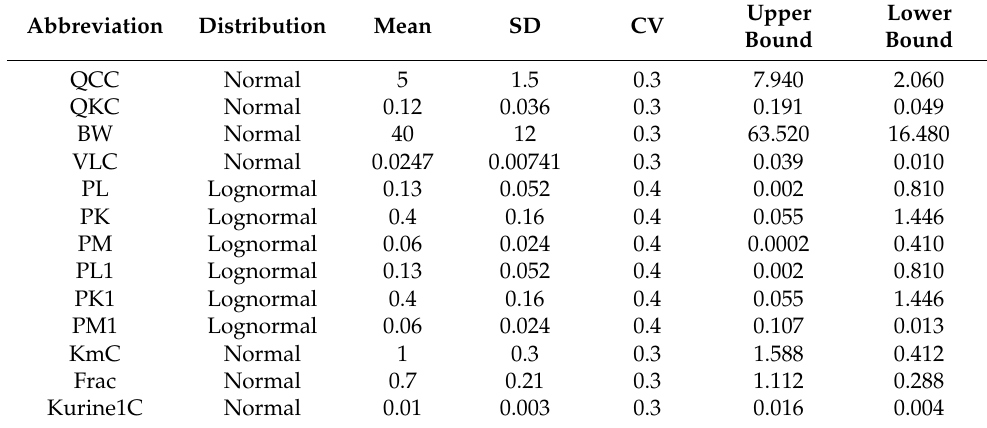
Table 4. Values and distributions of parameters used in the Monte Carlo analysis for the PBPK model.